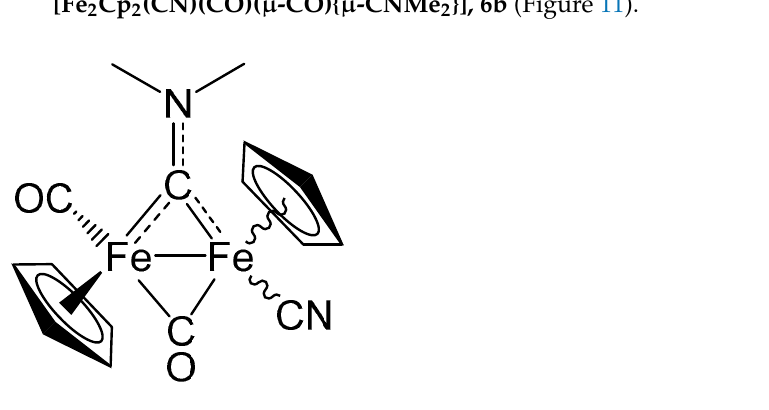
Figure 5. Structure of [Fe 2 Cp 2 (k N- NCO)(CO)(µ-CO){µ-CN(Me)(Me)}], 2b [39].